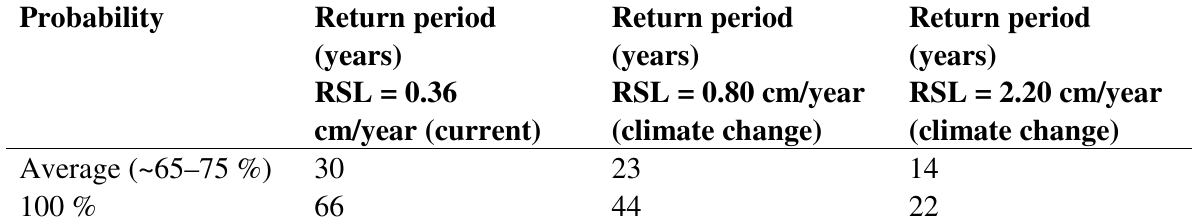
Table 1. Return periods (years) and probabilities of occurrence of the Groundhog Day storm water level (4.95 m) under current and projected sea-level rise conditions (from [35,41,50]). The return period has been rounded to the nearest year.